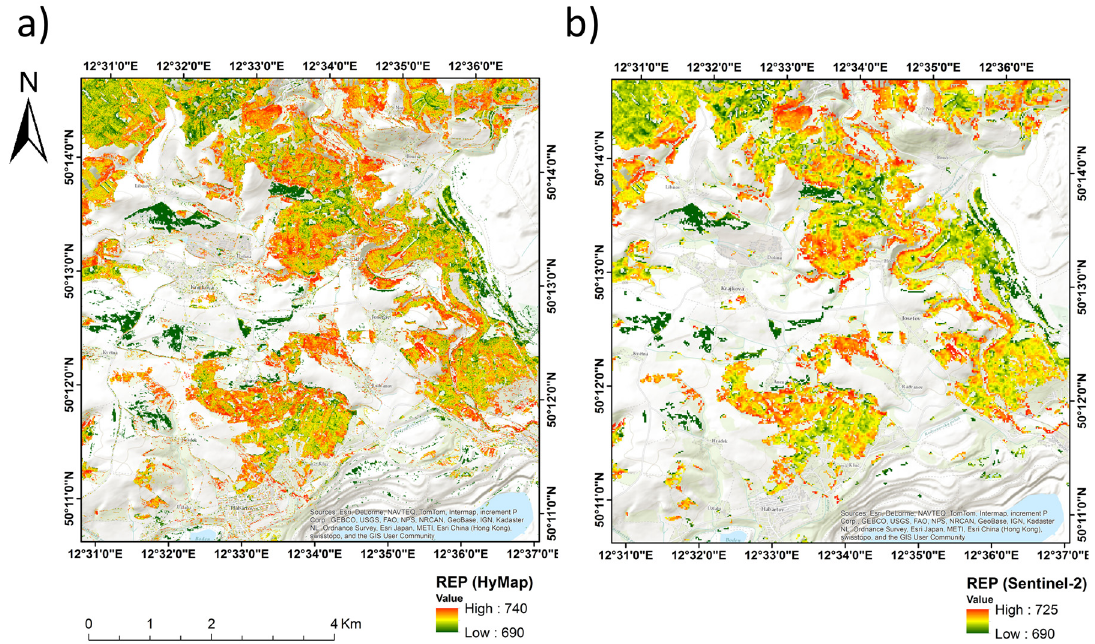
Figure 4. REP calculated from the 2009 ( a ) HyMap hyperspectral dataset (5-m spatial resolution) and ( b ) simulated S2 (20-m spatial resolution) dataset.